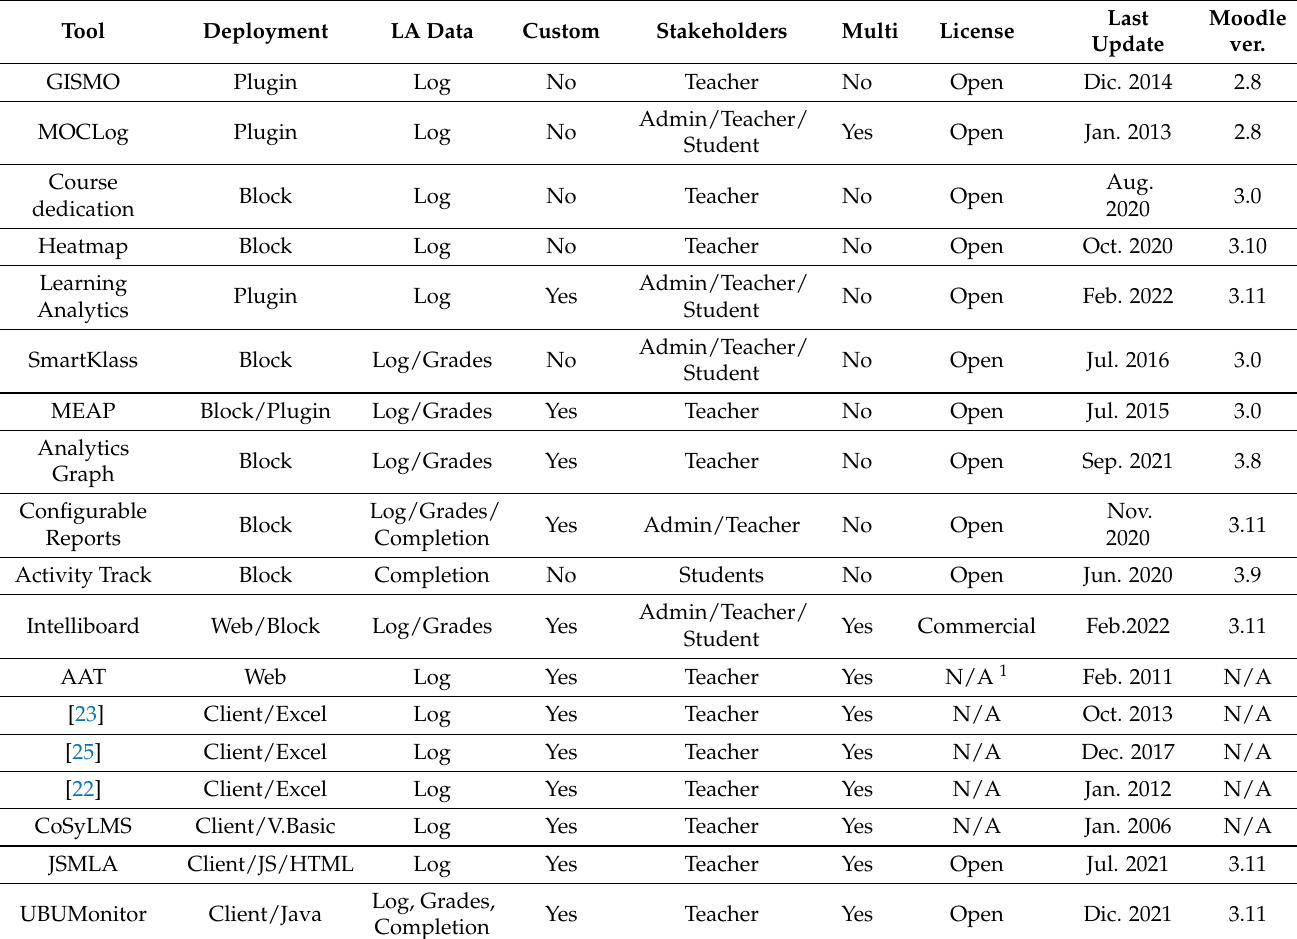
Table 1. Summary characterization of the analytical e-learning visualization